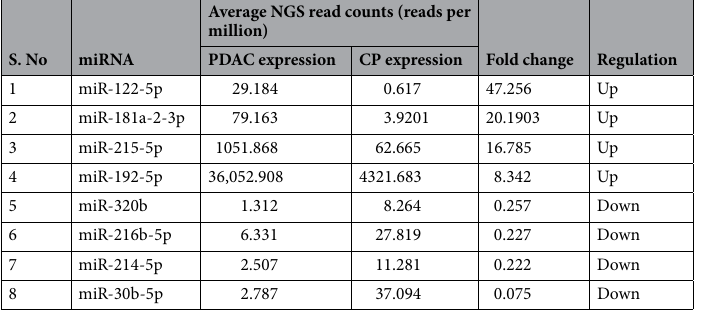
Table 1. List of 8 most differentially expressed miRNAs between PDAC and CP selected from NGS data.